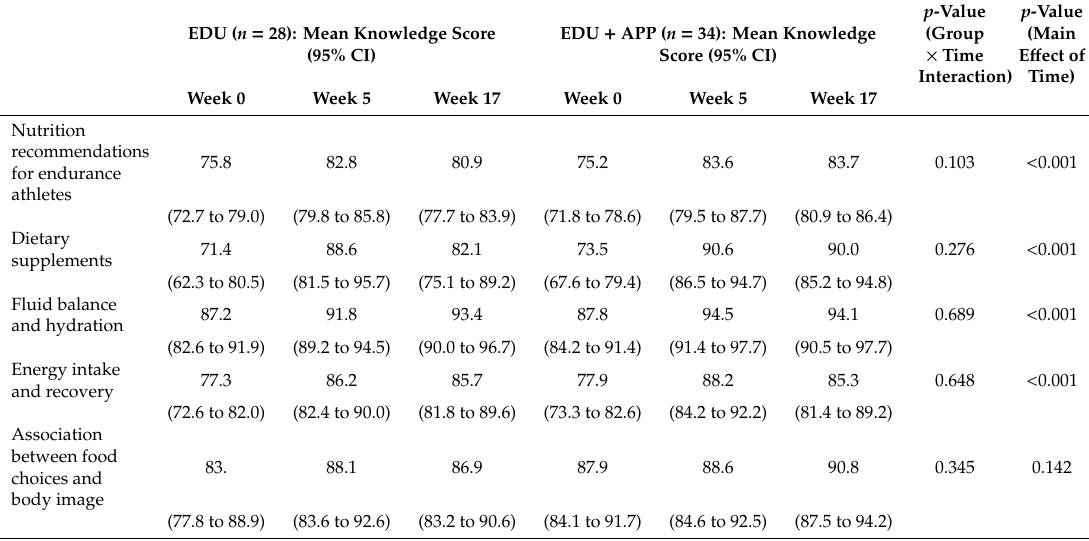
Table 2. Mean nutrition knowledge scores as percentages of correct answers (95% confidence intervals in parenthesis) in the di ff erent sections ( n = 5) of the